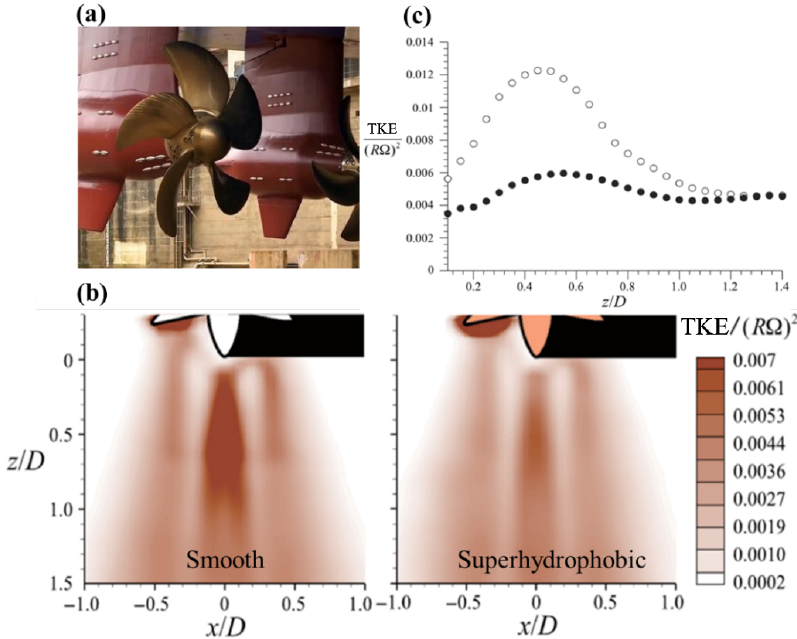
Fig. 12 Research on the TKE of ship propeller wake. (a) Typical ship propeller, (b) smooth surface propeller wake TKE (left) and superhydrophobic surface propeller wake TKE (right), and (c) propeller wake TKE changes at the centerline. ○ and ● denote the smooth surface and superhydrophobic surface, respectively. Reproduced with permission from Ref. [148], © Author(s) 2019.